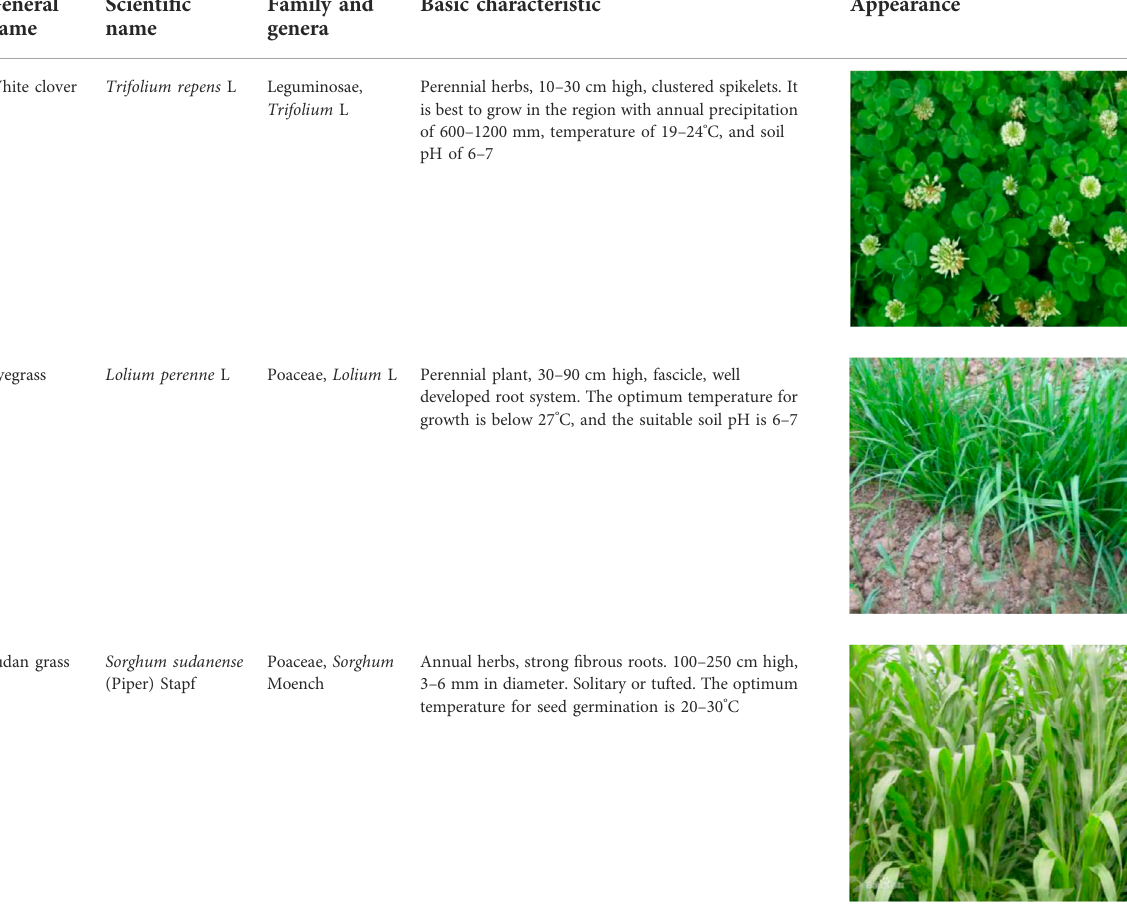
TABLE 2 Selected plants and their basic